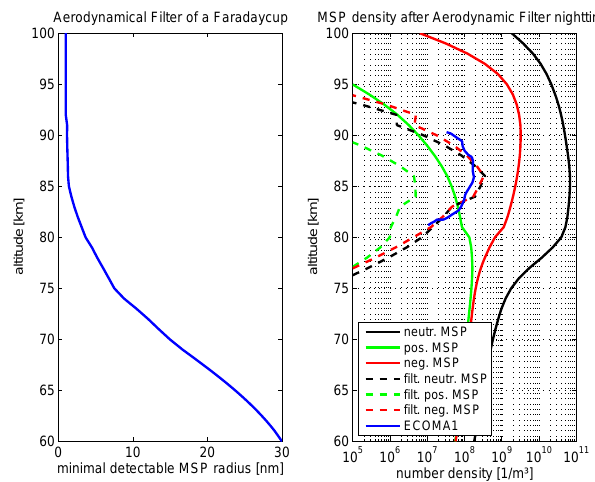
Fig. 8. Left panel: aerodynamical filter that applies to Faraday cup measurements of MSP with a rocket trajectory typical for previ- ous MSP measurements (Strelnikova et al., 2009) assuming a MSP mass density of 2gcm − 3 , right panel: filtered neutral, positive and negative MSP densities (dashed lines) compared to the original MSP densities and ECOMA-1